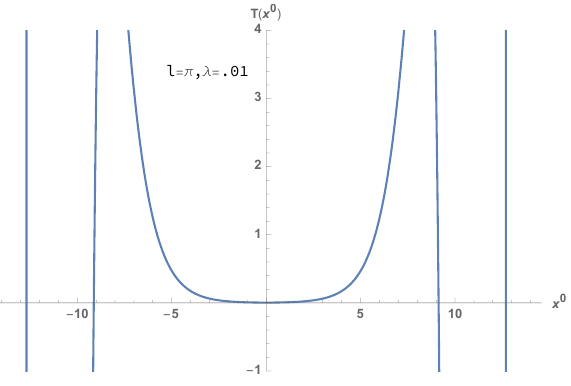
Figure 22 . Time evolution of the tachyon in the toy model for the cosh deformation at (cid:21) = : 01.